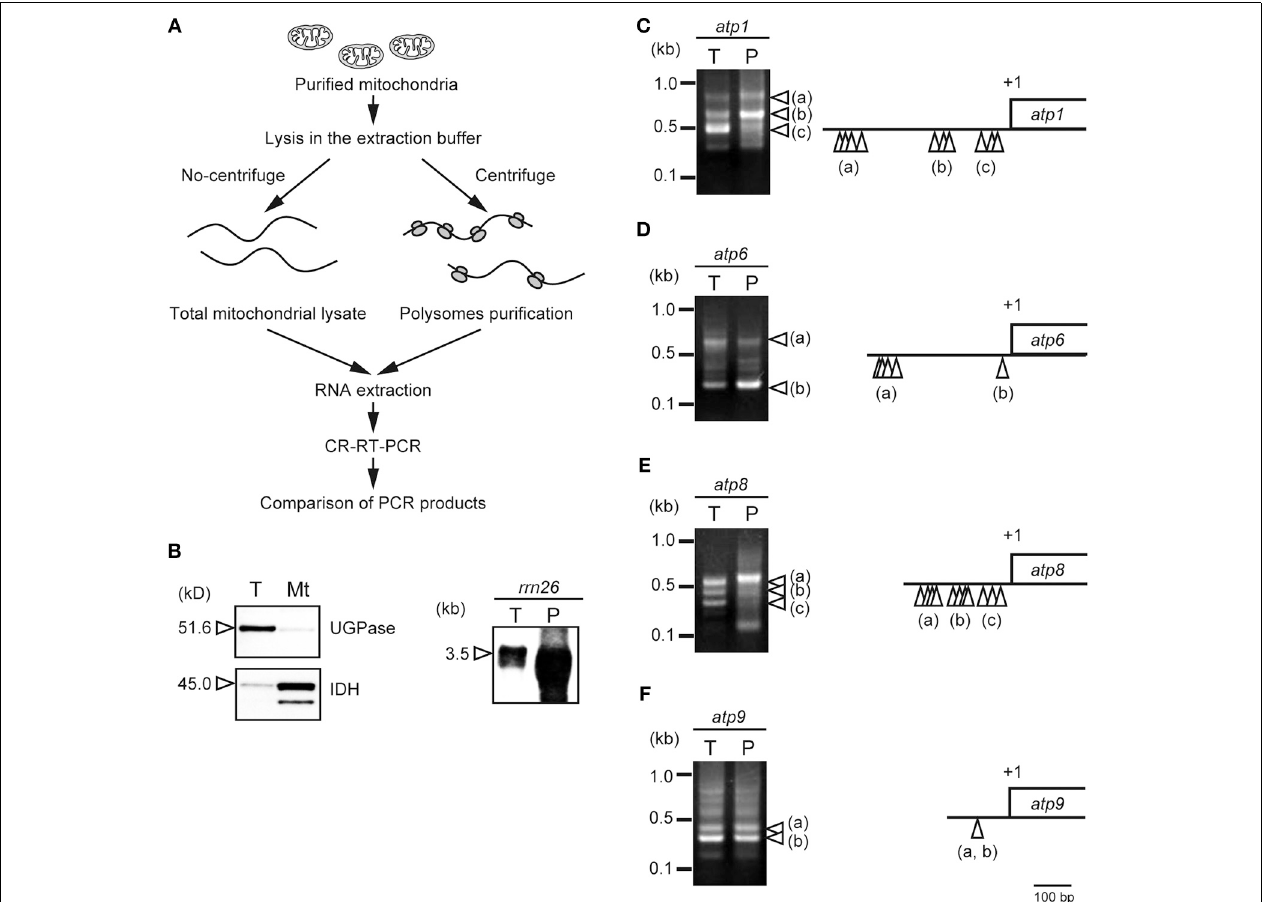
rotor (Beckman). The precipitate was used for polysomal fraction. (B) Purity of the isolated mitochondria was examined by a cytosolic marker protein of (UGPase, UDP-glucose pyrophosphorylase) and a mitochondrial marker protein (IDH, isocitrate dehydrogenase) (left panel). The western blot analyses were performed using total protein (T) and isolated mitochondria (Mt) using the specific antibodies (Agrisera). The enrichment of ribosomes in the polysomal fraction was also assessed by northern blot analysis in total mitochondrial RNA (T) and polysomal mitochondrial RNA (P) using rrn26 probe (right panel). The images of CR-RT-PCR were shown for mRNAs of atp1 (C) , atp6 (D) , atp8 (E) , and atp9 (F) . The 5 (cid:2) terminal of each transcript is indicated by white arrowheads in the CR-RT-PCR images mapped on the schematic gene structure (right